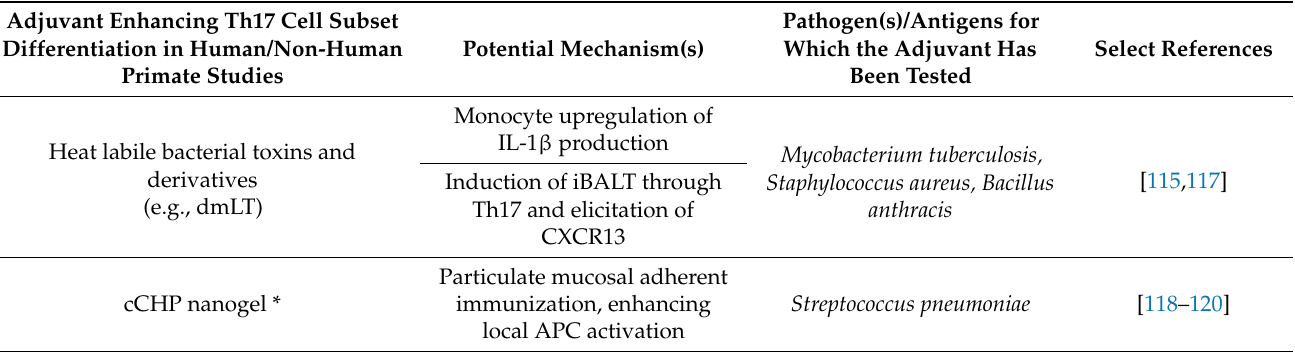
Table 5. Adjuvants enhancing Th17 cell subset differentiation in human/non-human primate studies. Adjuvant Enhancing Th17 Cell Subset Differentiation in